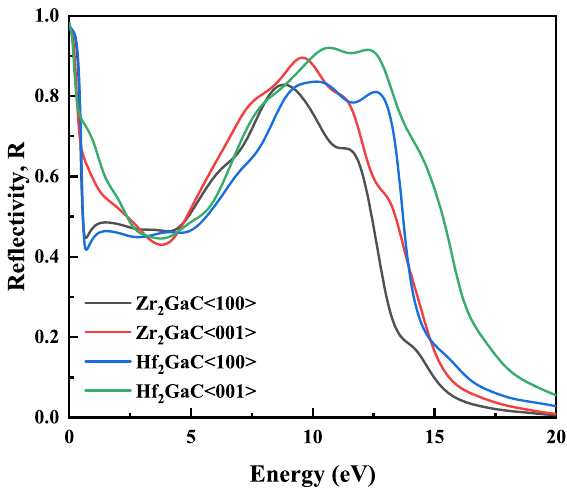
Figure 19. Reflectivity of M 2 GaC MAX phase (M = Zr, Hf) for <100> and <001> polarization.